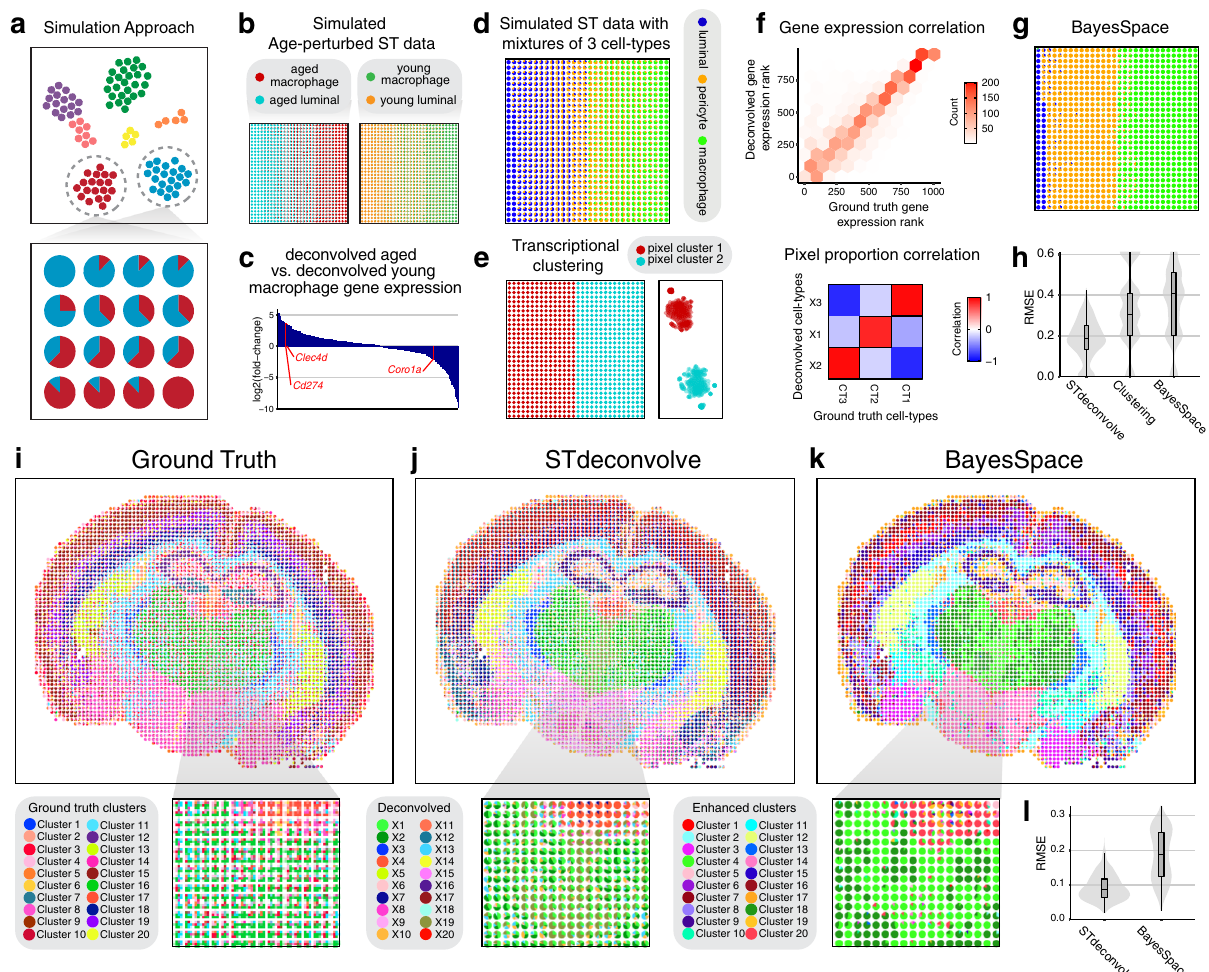
Fig. 3 Comparing clustering versus deconvolution analysis for ST data. a Overview of simulation approach. Starting from a single-cell RNA-seq clustering result visualized as a 2D t-SNE embedding with cells colored by cell type (top), gene expression counts from cells are combined to simulate cell-type mixtures, with the proportions of cell types are represented as pie charts for each arbitrary spatial pixel (bottom). b Simulated ST datasets of aged and young tissues using mixtures of aged macrophages with aged luminal cells and young macrophages with young luminal cells respectively represented as pie charts for each simulated ST pixel. c Bar chart of log 2 fold-change for deconvolved aged macrophage versus deconvolved young macrophage gene expression. Select genes are highlighted in red. d Simulated ST dataset with 3 cell types represented as pie charts for each simulated ST pixel. e Clustering analysis results of simulated ST dataset with 3 cell types. Pie chart proportional representation (left) and t-SNE representation (right). f Deconvolution results for the simulated ST dataset with 3 cell types by STdeconvolve. The ranking of each gene based on its expression level in the deconvolved cell-type transcriptional pro fi les compared to its gene rank in the matched ground truth cell-type transcriptional pro fi les (top). Heatmap of Pearson ’ s correlations between the deconvolved cell types proportions and ground truth cell types proportions across simulated pixels (bottom). g BayesSpace enhanced resolution clustering results for the simulated ST dataset with 3 cell types represented as pie charts. h Root-mean-square-error (RMSE) of the deconvolved cell-type proportions ( n = 900 pixels) compared to ground truth for the simulated ST dataset with three cell types. i Ground truth cell-type proportions derived from single-cell resolution MERFISH data of the mouse brain partitioned into 100 µ m 2 pixels. j Deconvolved cell-type proportions for the mouse brain by STdeconvolve. k Enhanced resolution clustering for the mouse brain by BayesSpace. Inset highlights an interior region corresponding approximately to the thalamus. l Root-mean-square-error (RMSE) of the deconvolved cell-type proportions ( n = 716 pixels) compared to single-cell clustering for the MERFISH mouse brain data for the inset interior region corresponding approximately to the thalamus. Boxplots indicate median (middle line), 25th, 75th percentile (box) and 5th and 95th percentile